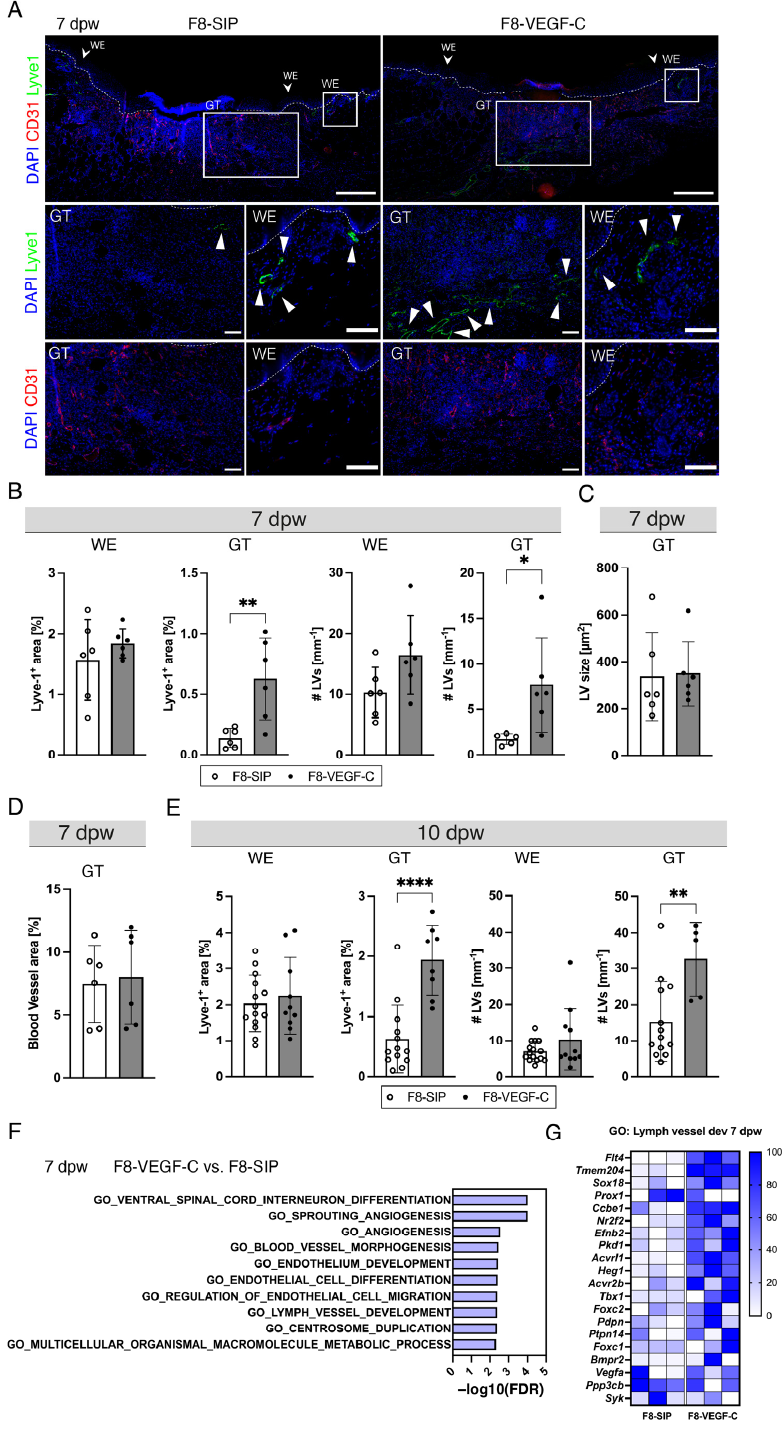
Figure 6. Targeted delivery of VEGF-C potently induces lymphangiogenesis in diabetic wounds. ( A ) Representative images of LYVE1 and CD31 stained sections of F8-SIP and F8–VEGF-C-treated db/db mice at 7 dpw. Magnifications of GT and WE are shown in LYVE1 and CD31, respectively. More LVs are present in the GT area of the F8–VEGF-C treated mice. The CD31+ area was comparable in the GT and the WEs in both groups. White arrowheads depict LVs. The white box indicates areas for magnified images. Scale bars: Overview 500 µ m, GT, WE: 200 µ m. ( B ) LYVE1+ area [%] and the number of LVs [mm − 1 ] at 7 dpw quantified next to the WE and in the GT. Quantification revealed a significant increase of LV area in the GT. The number of LVs per mm BM was significantly